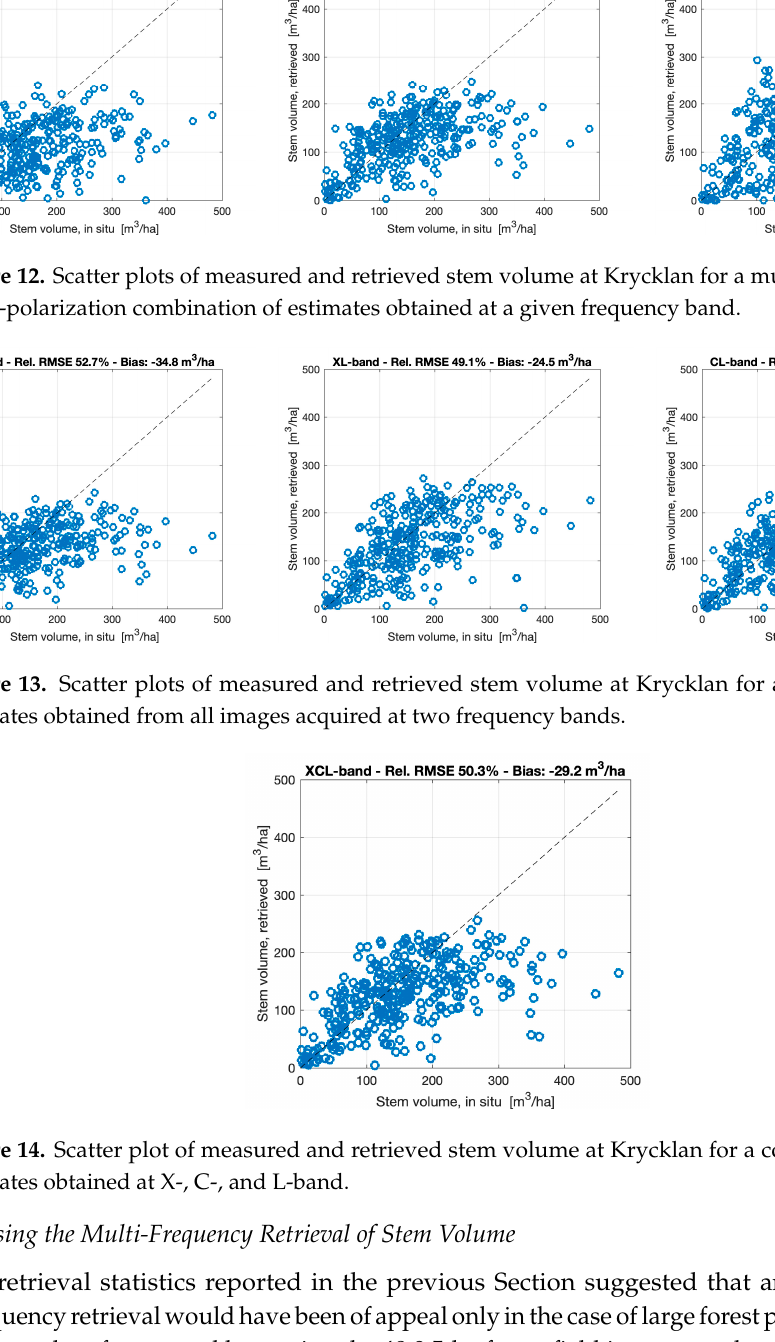
Figure 11. Scatter plots of measured and retrieved stem volume at Krycklan for a multi-temporal combination of estimates obtained at a given frequency band and polarization.